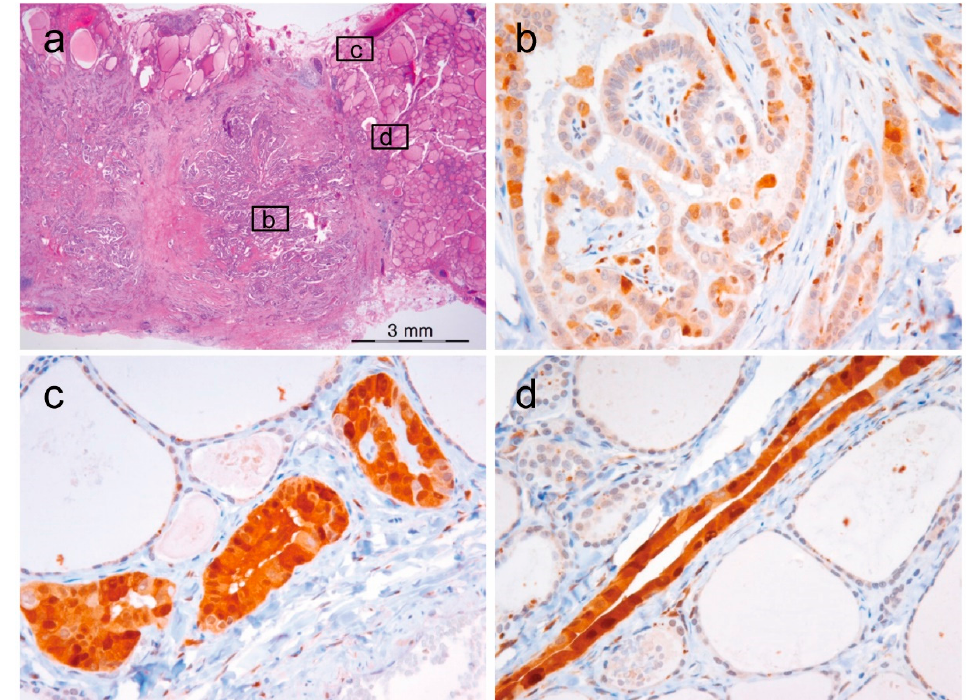
Figure 4. Heterogeneous immunostaining for cyclin D1b in papillary thyroid carcinoma. ( a ) Low magnification (×12) shows a classical papillary thyroid carcinoma with insets corresponding to high-power view of immunostaining for cyclin D1b shown in ( b – d ). ( b ) The central areas show a patchy